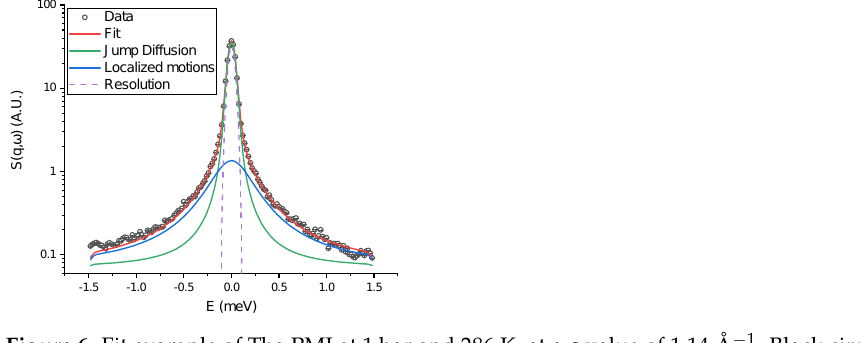
Figure 6. Fit example of Tba PMI at 1 bar and 286 K, at a q value of 1.14 Å − 1 . Black circles represent the corrected data, the two Lorentzian contributions owing to localized motions and jump–diffusion are shown respectively as blue and green solid lines, and the total fit is shown as a red solid line. The resolution function is also shown. Error bars are smaller than the symbol size.